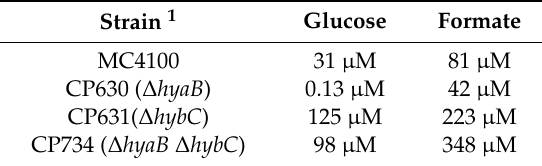
Table 2. Apparent EC 50 values of CCCP